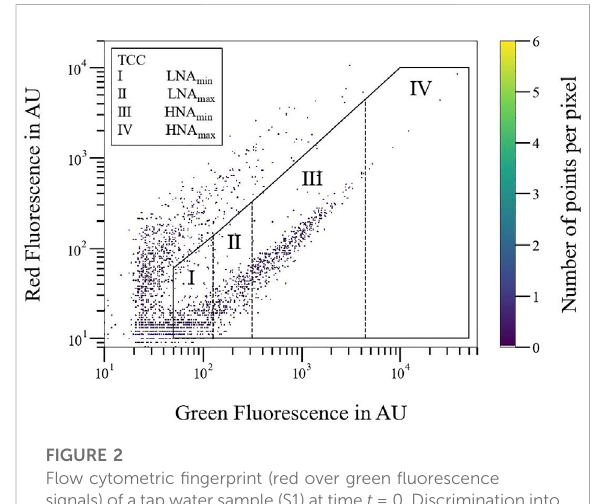
FIGURE 2 Flow cytometric fi ngerprint (red over green fl uorescence signals) of a tap water sample (S1) at time t = 0. Discrimination into overall TCC (2 . 0 × 10 4 cells/ml), LNA min ( 5 . 8 × 10 3 cells/ml ) , LNA max (4 . 5 × 10 3 cells/ml), HNA min (9 . 9 × 10 3 cells/ml), and HNA max (0 . 2 × 10 3 cells/ml) gates. LNA summarizes both LNA min and LNA max signals whereas HNA summarizes both HNA min and HNA max signals.